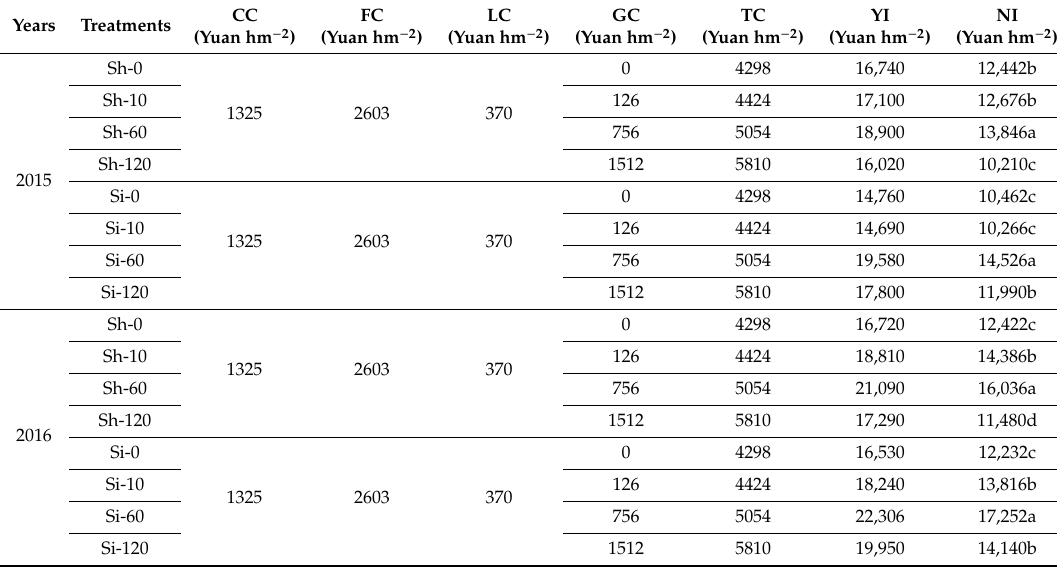
Table 4. Economic benefit analysis of applying GA 4 + 7 in